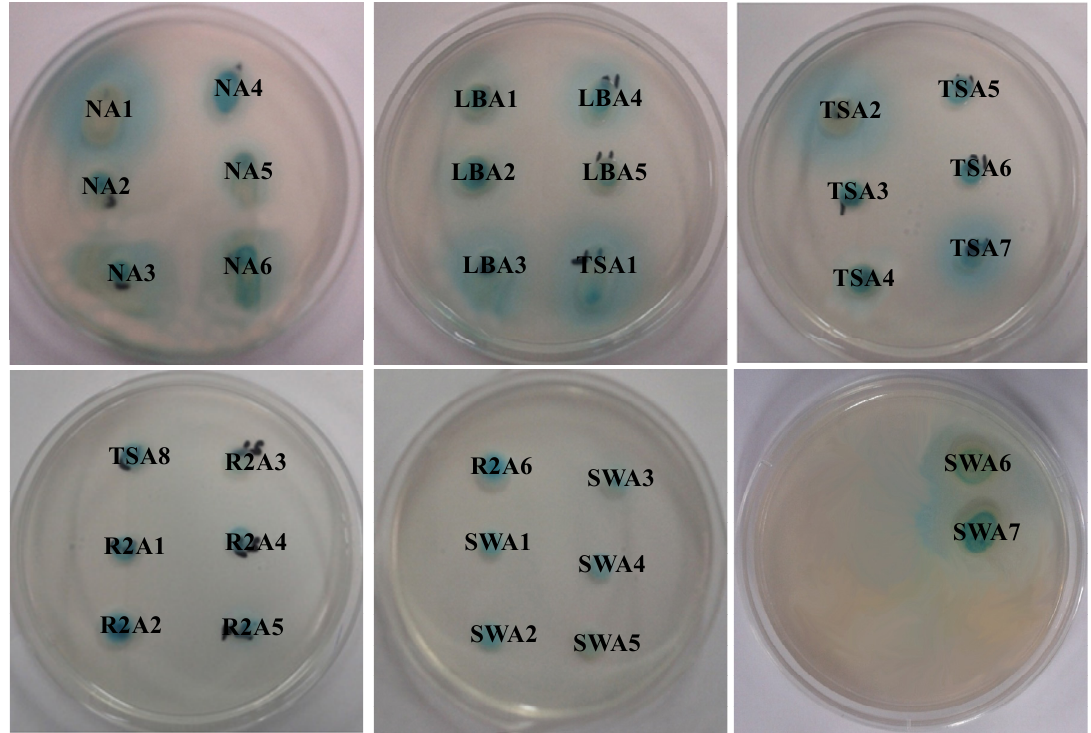
Figure 2. Screening of bacterial isolates for AHLs production using agar-plate well diffusion assay with A. tumefaciens A136. All the thirty two isolates producing medium and long-chain AHLs are